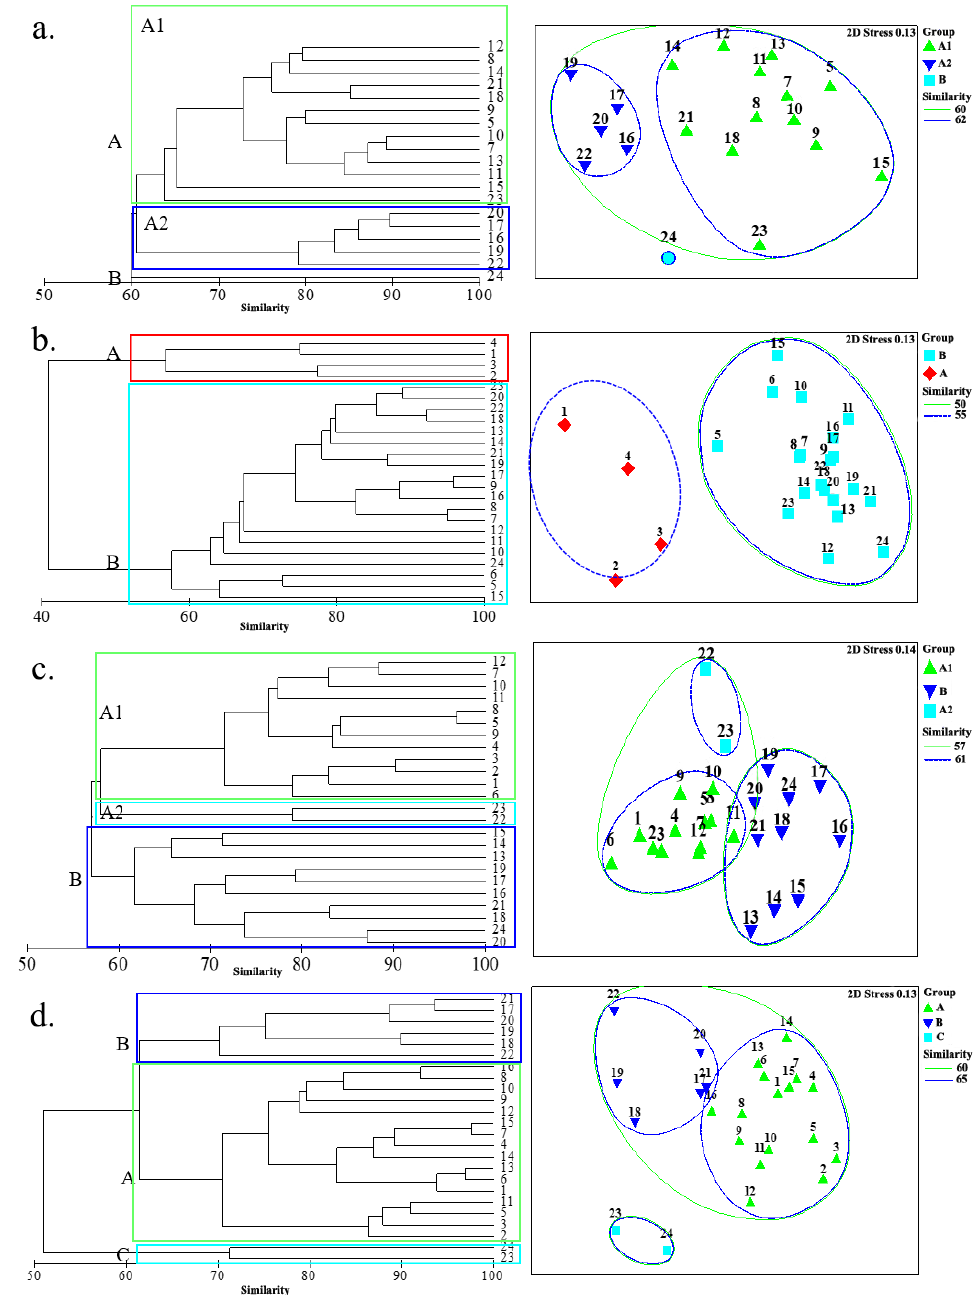
FIGURE 8 Figure 8. Dendrogram of station similarity from the cluster analysis (left) and ordination plots based on non-metric multidimensional scaling (right) of copepod abundance in Doam Bay: ( a ) spring, ( b ) summer, ( c) fall, ( d ) winter. Numbers correspond to the stations within the bay. Capital letters A, B, and C represent groups of stations distinguished based on species similarity. A1 and A2 are subgroups subdivided by species similarity within group